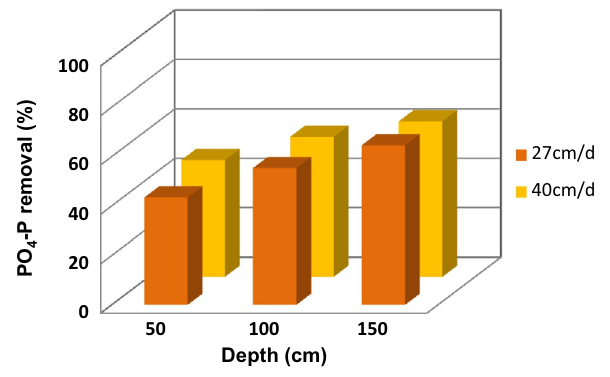
Fig. 2 Mean PO 4 -P removal rates along the sand filter profile for two hydraulic loads (27 and 40 cm day −1